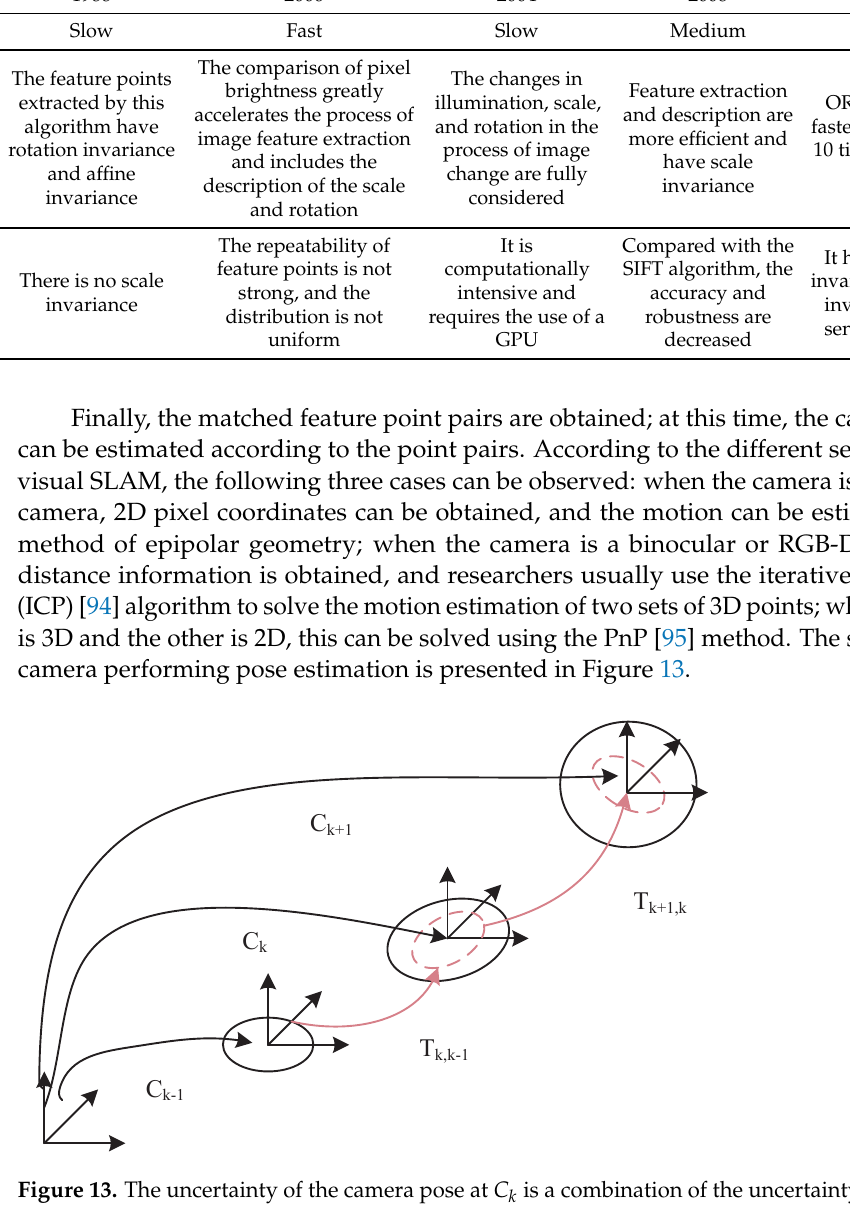
Figure 13. The uncertainty of the camera pose at C k is a combination of the uncertainty at C k − 1 (black solid ellipse) and the uncertainty of the transformation T k , k − 1 (gray dashed ellipse). Reproduced with permission of Ref. [34], Copyright of 2012 IEEE Robotics & Automation